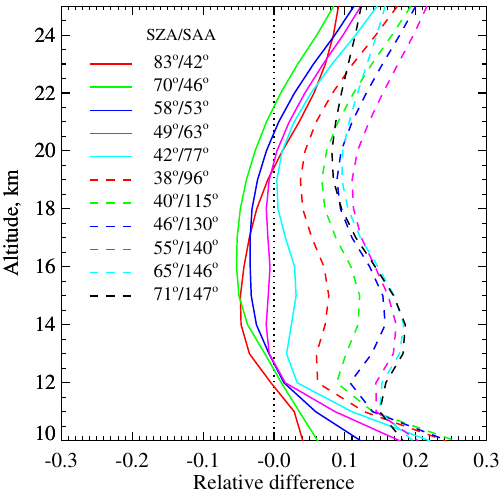
Fig. 13. Aerosol extinction profiles at 1352nm for different LOW- TRAN